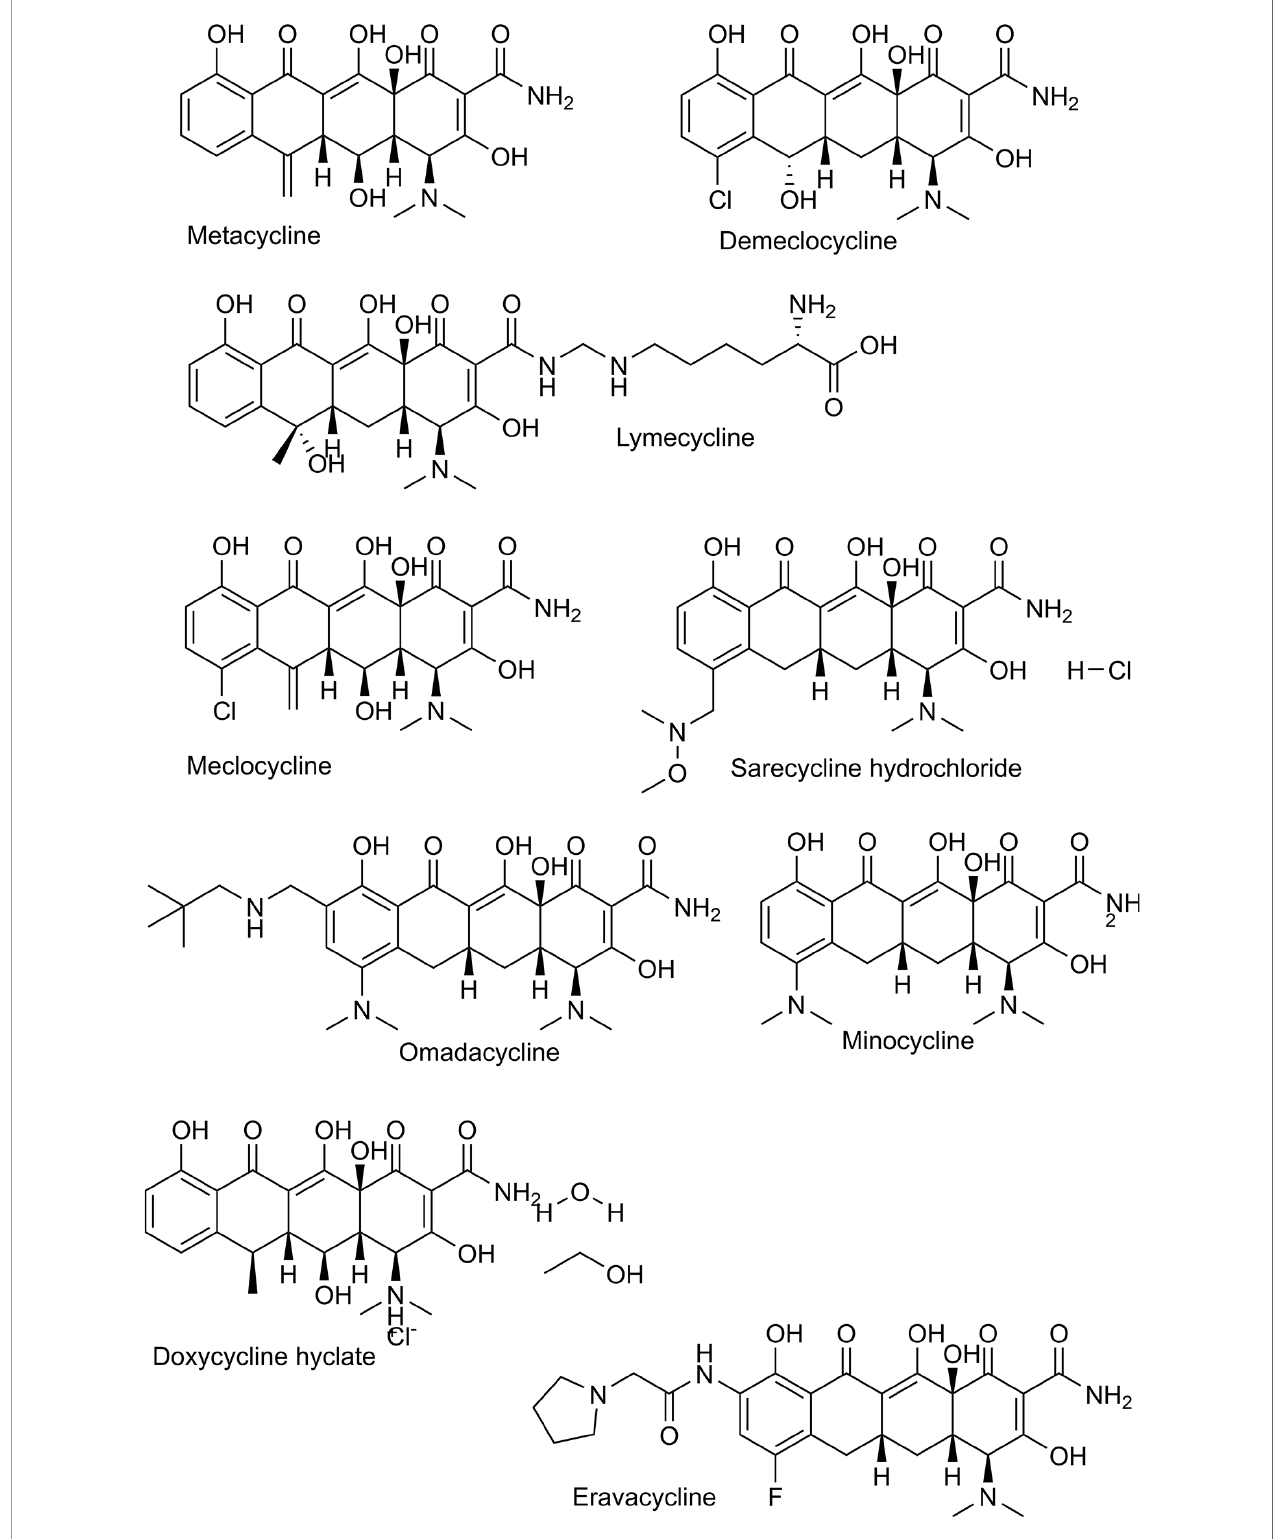
FIGURE 1 | Chemical structures of tetracyclines tested in this